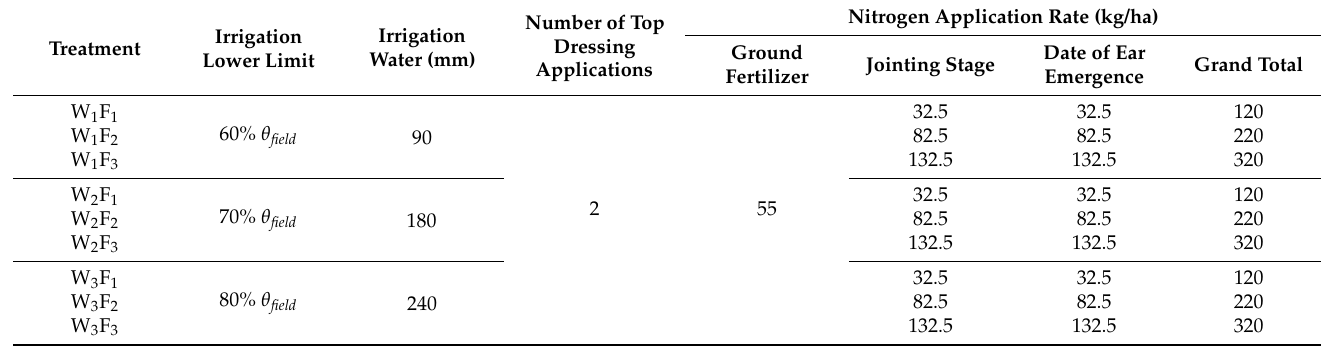
Table 2. Different water and fertilizer treatments for winter wheat.